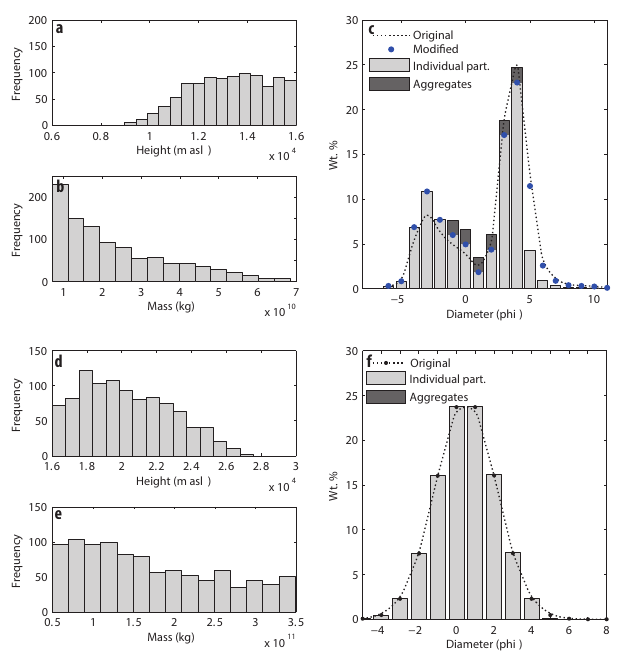
Figure 4. ESP used for (a–c) the Hekla 2000-type and (d–f) the Hekla 1947-type scenarios (see Table 3 for details). (a) and (d) : plume height (ma.s.l.); (b) and (d) : erupted mass; (c) and (f) : to- tal grain-size distribution. Histograms in (c) and (f) show both the fractions of individual particles (light grey) and aggregates (dark grey) generated based on the algorithm explained in the text; origi- nal indicates the original grain-size distribution obtained from siev- ing (i.e. not containing any